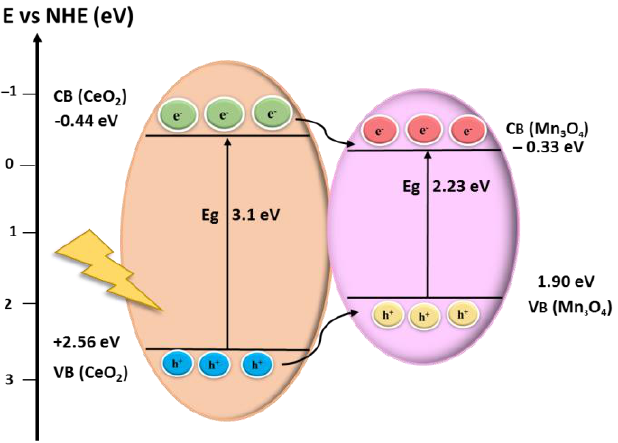
Figure 13. The proposed mechanism of Mn-doped porous ceria in the decolorization of MG dye with the assumption that Mn ions were presented as a separate Mn 3 O 4 phase.